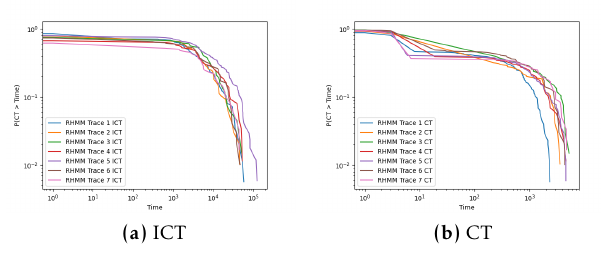
Figure 6. Contact and Inter-Contact Times of 7 RHMM Synthetic Traces